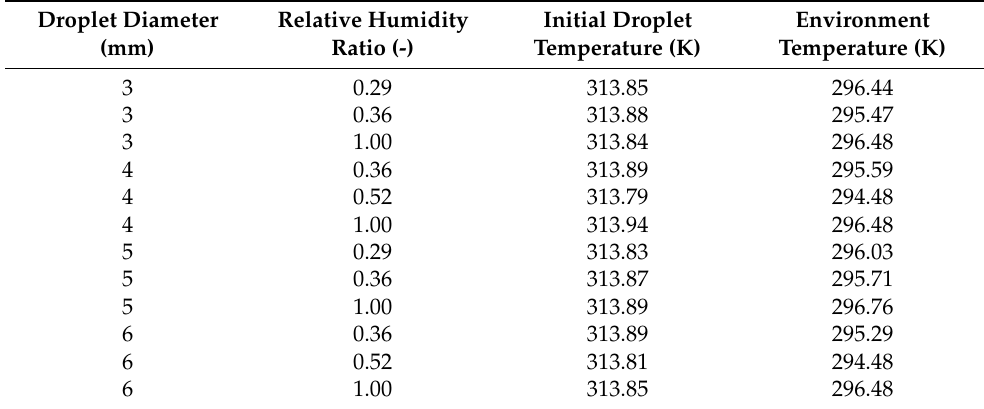
Table 2. Experimental test matrix [44].